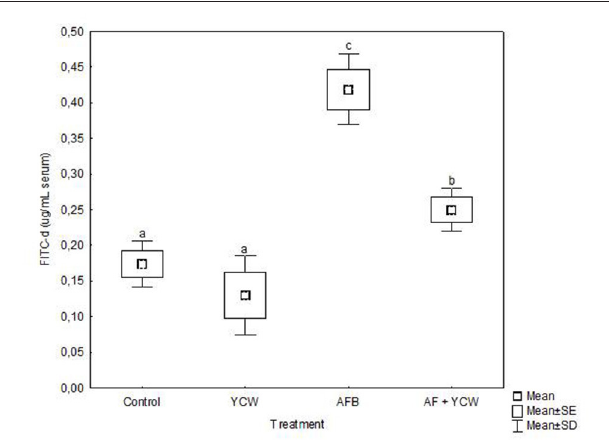
FIGURE 5 | Serum fluorescein isothiocyanate dextran (FITC-d) levels in broiler chickens at 21 days of age. Mean of five replicates of three chicks each per treatment ( n = 15). Boxes and whiskers not sharing a common superscript differ significantly (Tukey test P <